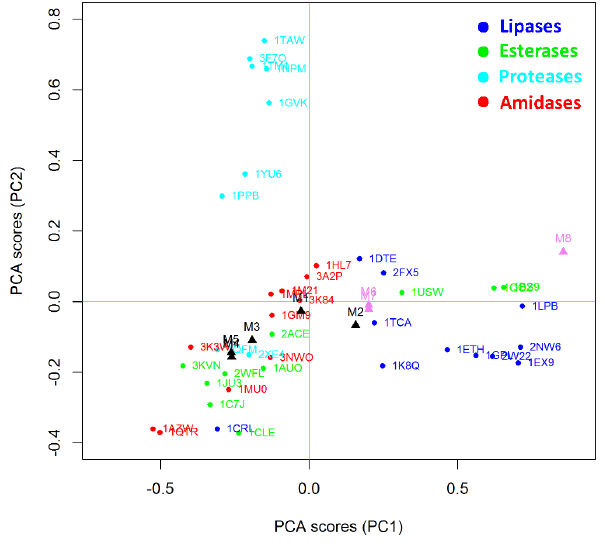
Figure 11. Unsupervised Pattern Cognition Analysis (UPCA) of BioGPS descriptors generated by DRY probe (hydrophobicity). The analyzed enzymes are labelled according to their PDB code and colored as in figure 3. Improved mutants are highlighted in black triangles and poor mutants are in pink triangles.